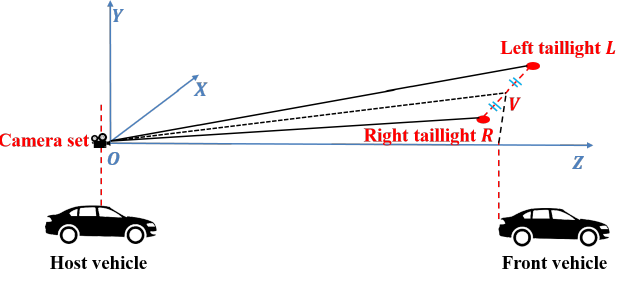
Figure 3. Estimate the front vehicle’s world coordinates based on its taillight